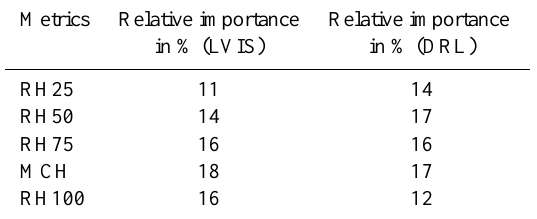
Table 1. Relative importance of each metric in a power law model (1ha scale). All five metrics together explain 75% of the model. MCH has the highest relative importance for both LVIS and DRL models.